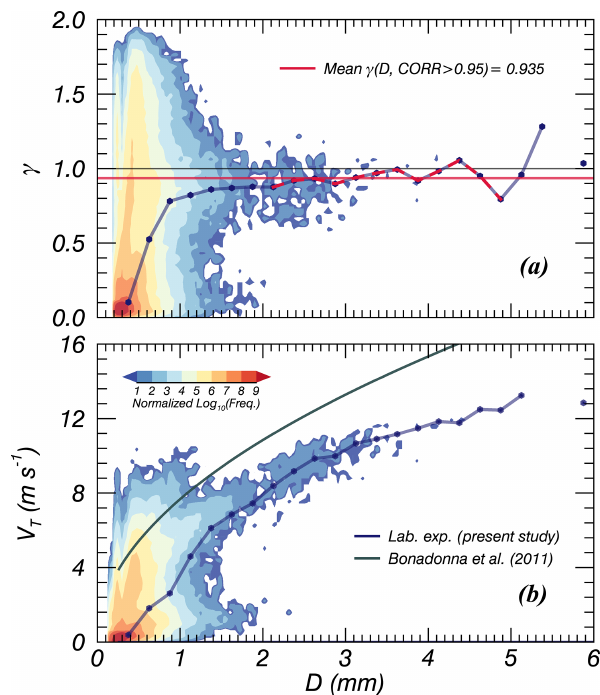
Figure 7. Contour image of volcanic ash particles for (a) the axis ratio ( γ ) and (b) terminal velocity ( V T ). The solid red line is the averaged γ satisfying the condition that the correlation coefficient exceeds 0.95. The solid grey line is the relationship of volcanic ash particles suggested by Bonadonna et al.